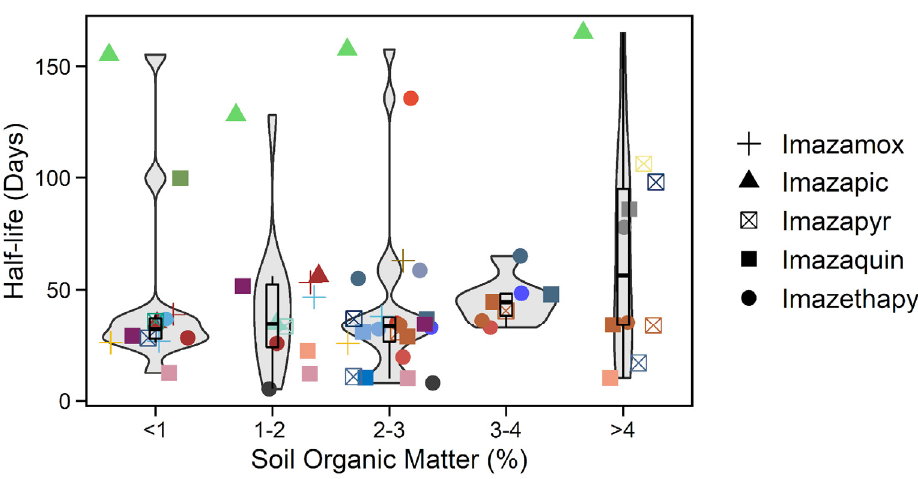
Figure 6. Half-life of imidazolinones (days) at different soil organic matter contents (%).